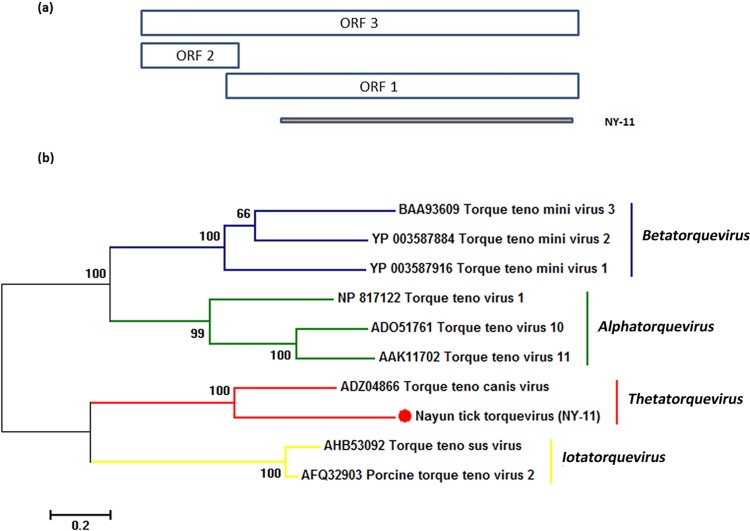
Phylogenetic analysis of tick thetatorquevirus-related sequences.(a) Schematic representation of three ORFs for Thetatorquevirus. The orange bar represents the contig sequence from NY-11. (b) Phylogenetic analysis of the selected contig related to Thetatorquevirus is based on an alignment with the predicted 440 amino acid sequence of ORF1. Thetatorquevirus and three other genera from the Anelloviridae family are indicated on the right of the tree.